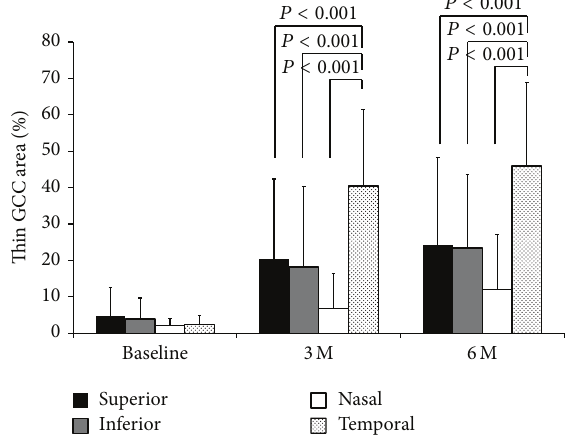
Figure 4: The percentage of thin GCC areas at the superior, inferior, temporal, and nasal quadrants. The difference of the percentage of thin GCC area was significant between quadrants at 3 and 6 months postoperatively ( 𝑃 < 0.001 and 𝑃 < 0.001 , Kruskal-Wallis test). The percentageofthinGCCareawassignificantlygreateratthetemporal quadrant at 3 and 6 months (versus superior, 𝑃 < 0.001 and 𝑃 < 0.001 ; versus inferior, 𝑃 < 0.001 and 𝑃 < 0.001 ; versus nasal, 𝑃 < 0.001 and 𝑃 < 0.001 , Mann-Whitney